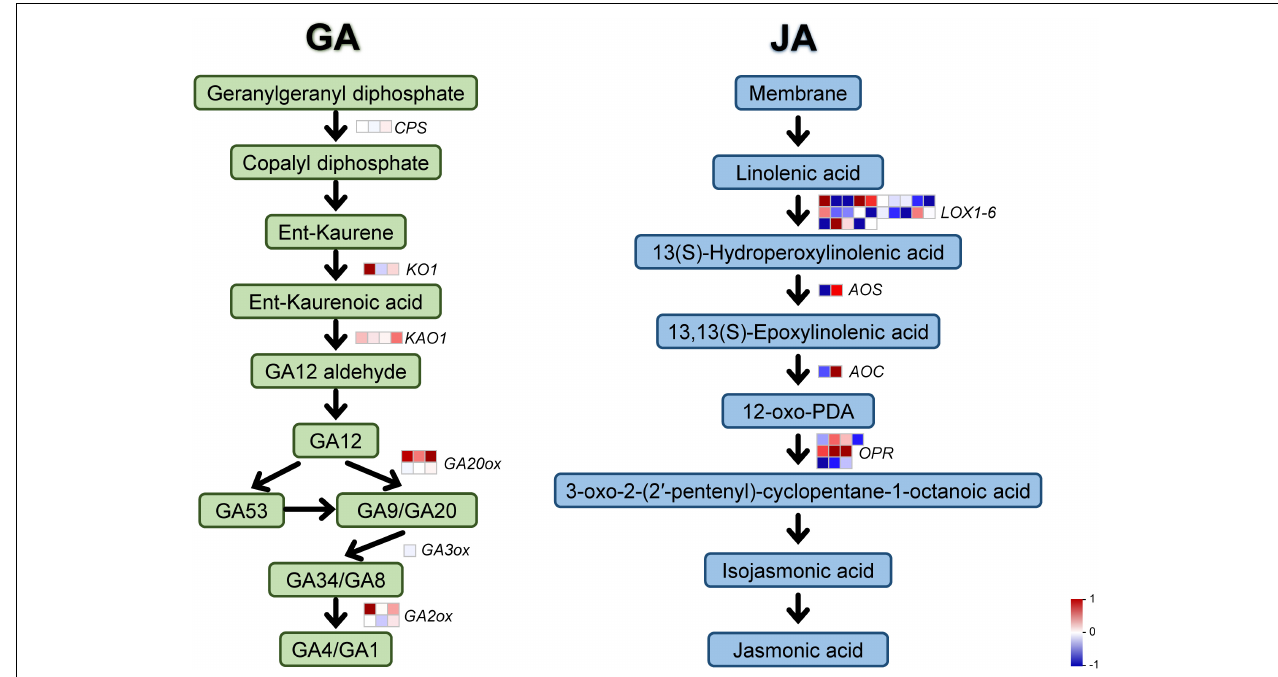
FIGURE 3 | Synthesis pathway of GA and JA. The GA and JA synthesis pathway were distinguished using green and blue, rounded rectangle represented a synthesis product, arrows represented the synthesis process, squares represented the key genes in this synthesis process. The differential expression fold-change were homogenized. Red represents up regulation and blue represents down